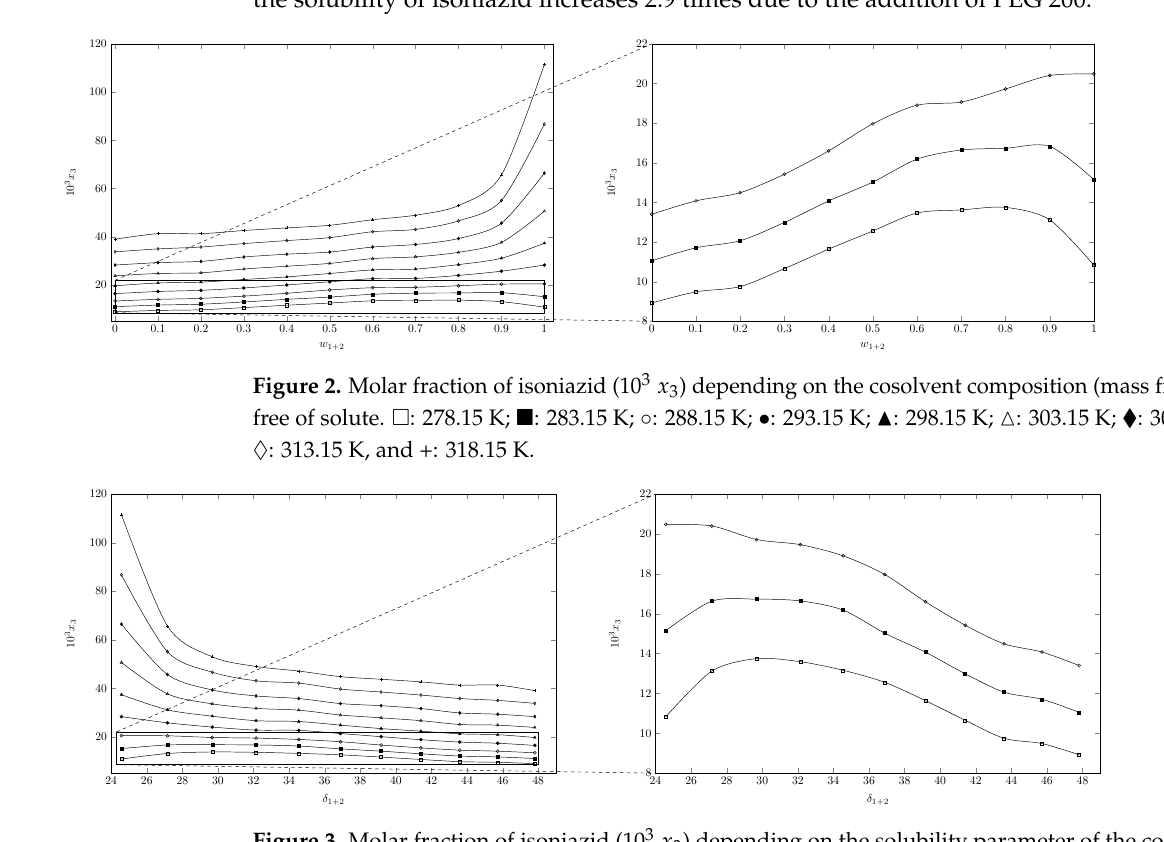
Figure 3. Molar fraction of isoniazid (10 3 x 3 ) depending on the solubility parameter of the cosolvent mixture free of solute. (cid:3) : 278.15 K; (cid:4) : 283.15 K; (cid:7) : 308.15 K; ♦ : 313.15 K, and +: 318.15